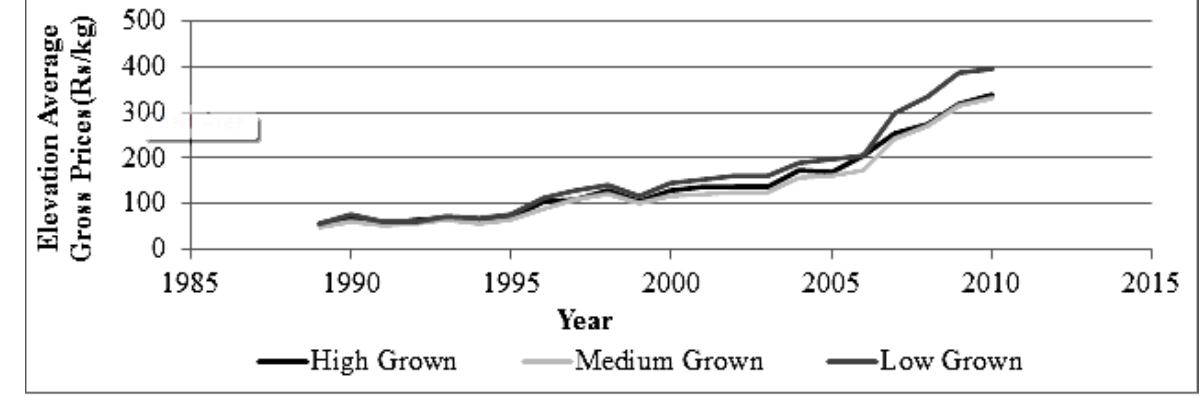
Fig 1: Elevation Average (EA) of Gross Price at Colombo